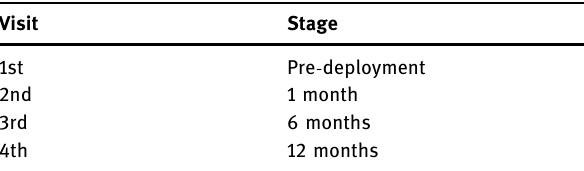
Table 4: Original planned visit schedule